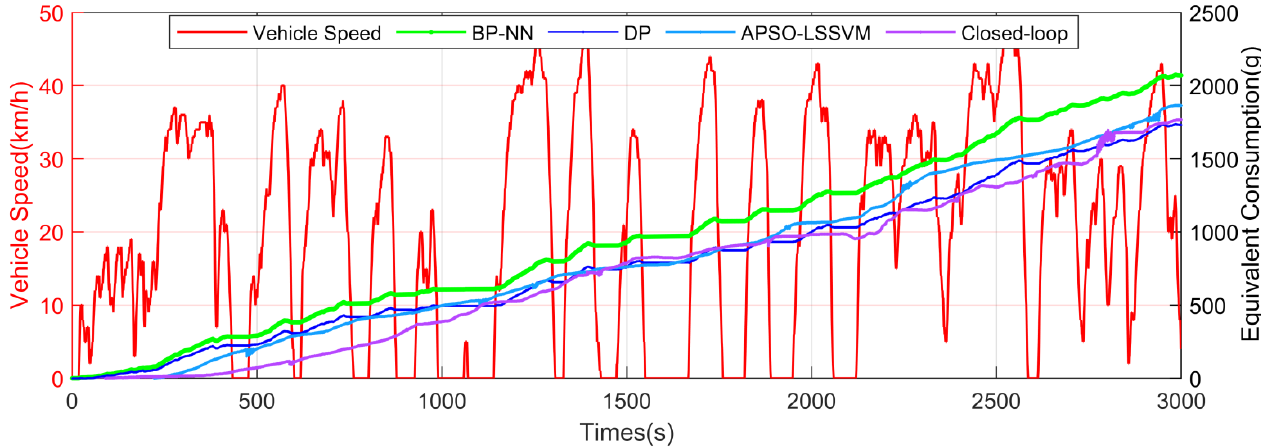
Figure 12. Changes of equivalent hydrogen fuel consumption. Table 6. EMS simulation results.